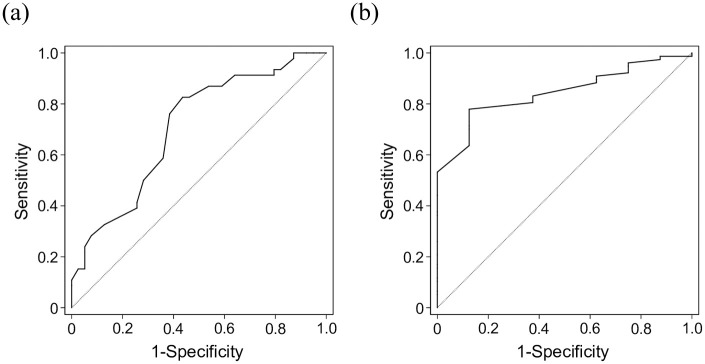
(a). ROC curve for the correlation between PSA bounce and age. The area under the ROC curve was 0.705. The cut-off value was 68 years, at which the sensitivity and specificity were 76.1 and 61.5%, respectively. (b). ROC curve for the correlation between PSA bounce and age. The area under the ROC curve was 0.844. The cut-off value was 65 years, at which the sensitivity and specificity were 77.9 and 87.5%, respectively.